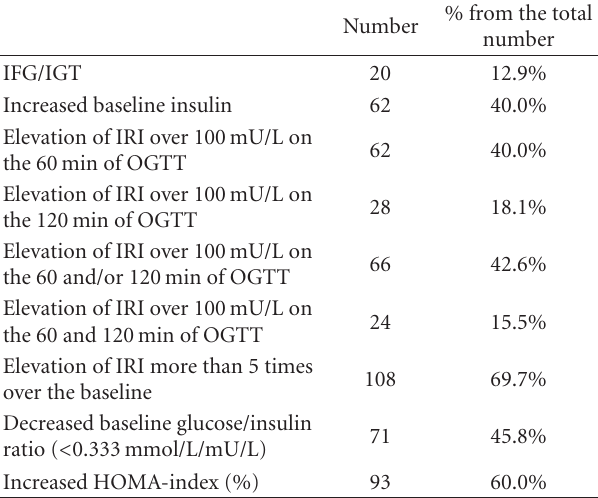
Table 8: Insulin resistance according to di ff erent criteria in the general group ( n =